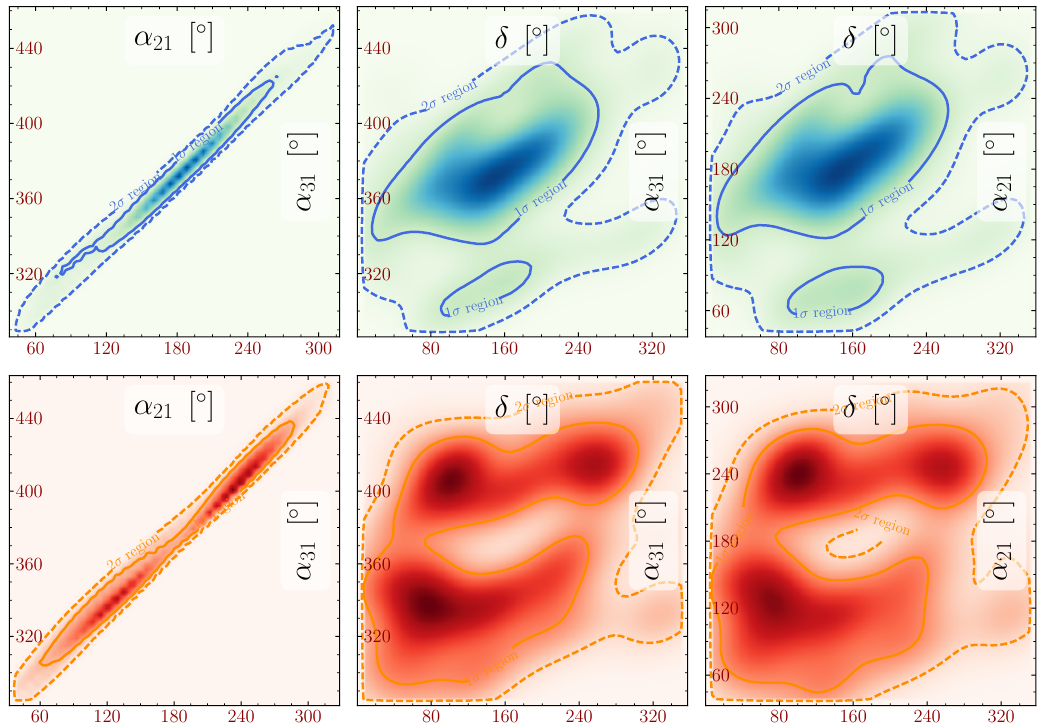
Figure 9 . The two-dimensional projections for intermediate scale leptogenesis with M 1 = 1 : 29 10 8 GeV for x 1 = 0, y 2 = 0, x 3 = 180 (cid:14) , y 1 = y 2 = 180 (cid:14) , with CP violation provided only by the phases of the PMNS matrix. The normal ordered case is coloured blue/green and inverted ordering orange/red and contours correspond to 68% and 95% con(cid:12)dence levels. This plot was created using SuperPlot